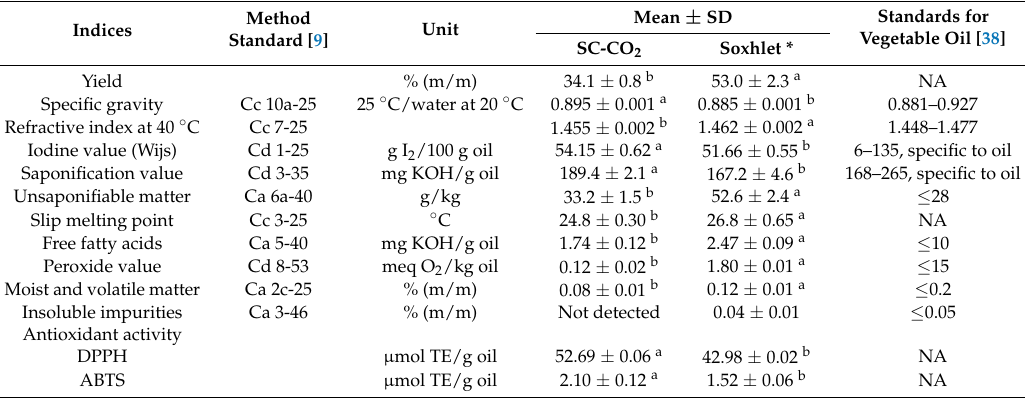
Table 2. Yield, physicochemical characteristics and antioxidant activity of Gac seed oil obtained by supercritical (SC)-CO 2 and